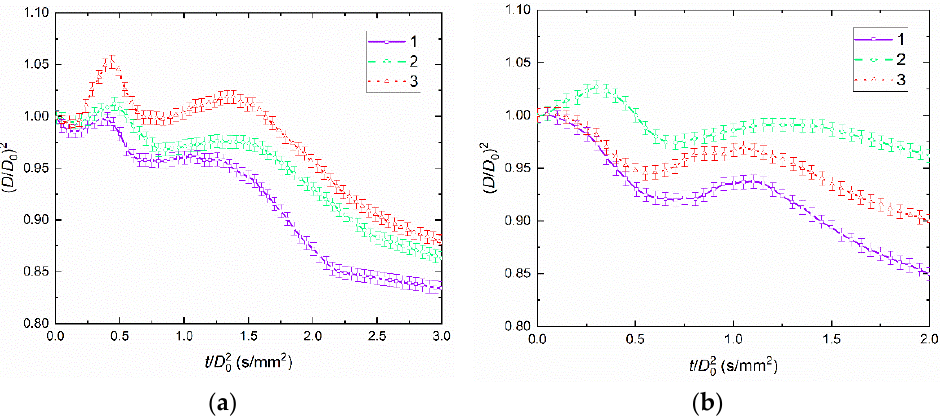
Figure 4. Temporal characteristics of droplet evaporation and drying until breakup for blends K50W49LI1 ( a ) and K50W49D1 ( b ) ( R d0 = 1.3 ± 0.1 mm): 1 — T a = 950 ± 30 K; 2 — T a = 1050 ± 30 K; K50W49LI1 ( a ) and K50W49D1 ( b ) ( R d0 = 1.3 ± 0.1 mm): 1— T a = 950 ± 30 K; 2— T a = 1050 ± 30 K; 3 — T a = 1150 ± 30 K. 3— T a = 1150 ± 30